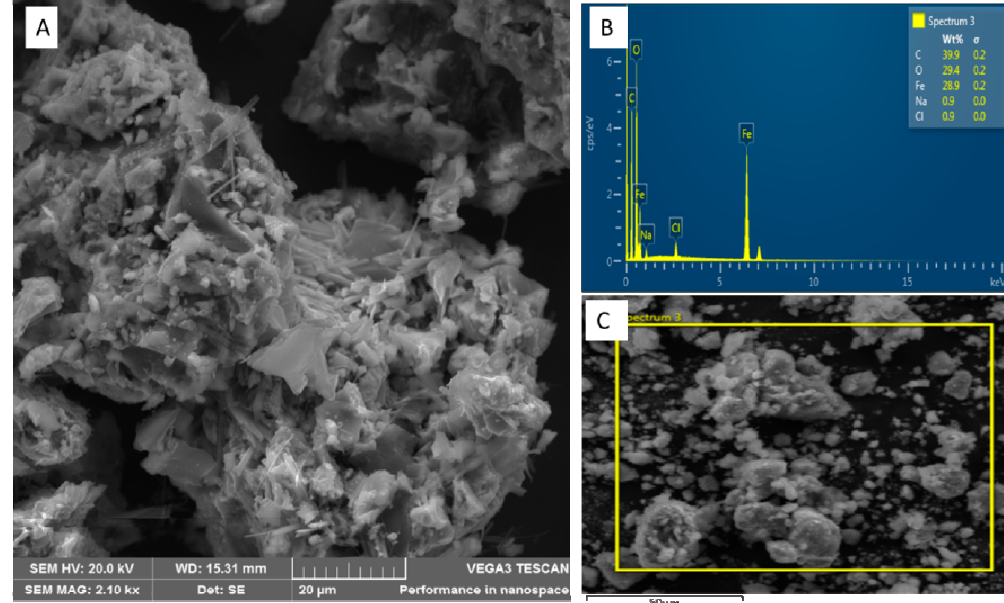
Figure 3. An exemplary ( A ) SEM image and ( B ) EDX spectrum and ( C ) section analysed using EDX of the akaganeite nanomaterial synthesized in absence of a surfactant.